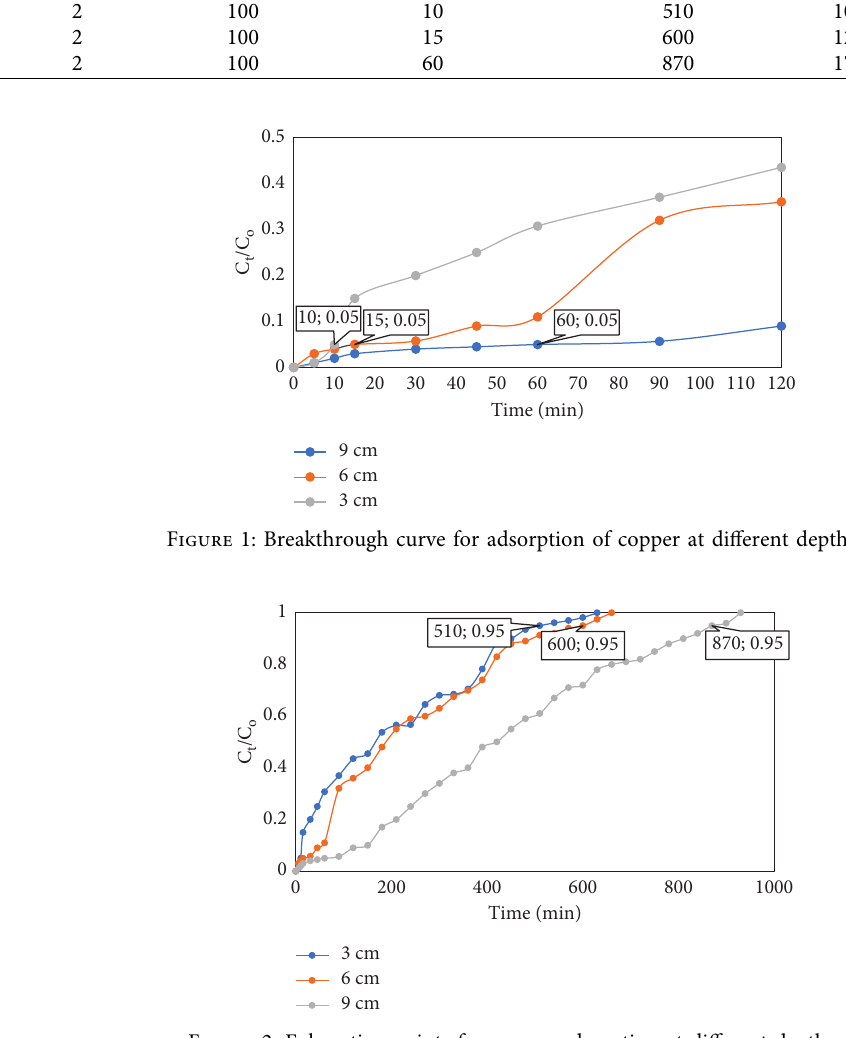
Figure 2: Exhausting points for copper adsorption at different depths. Table 3: Column performance in cadmium removal at different bed